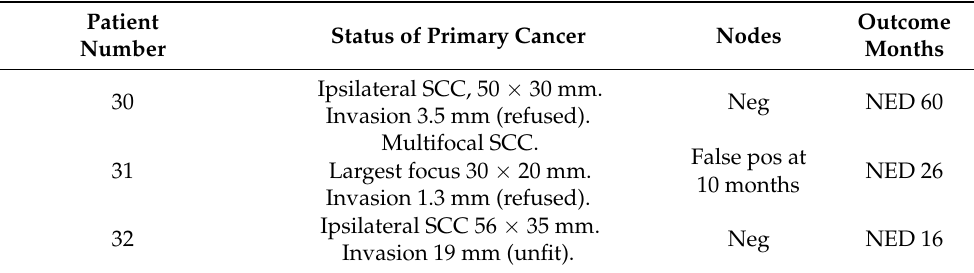
Outcome Months Neg NED 60 False pos at NED 26 10 months